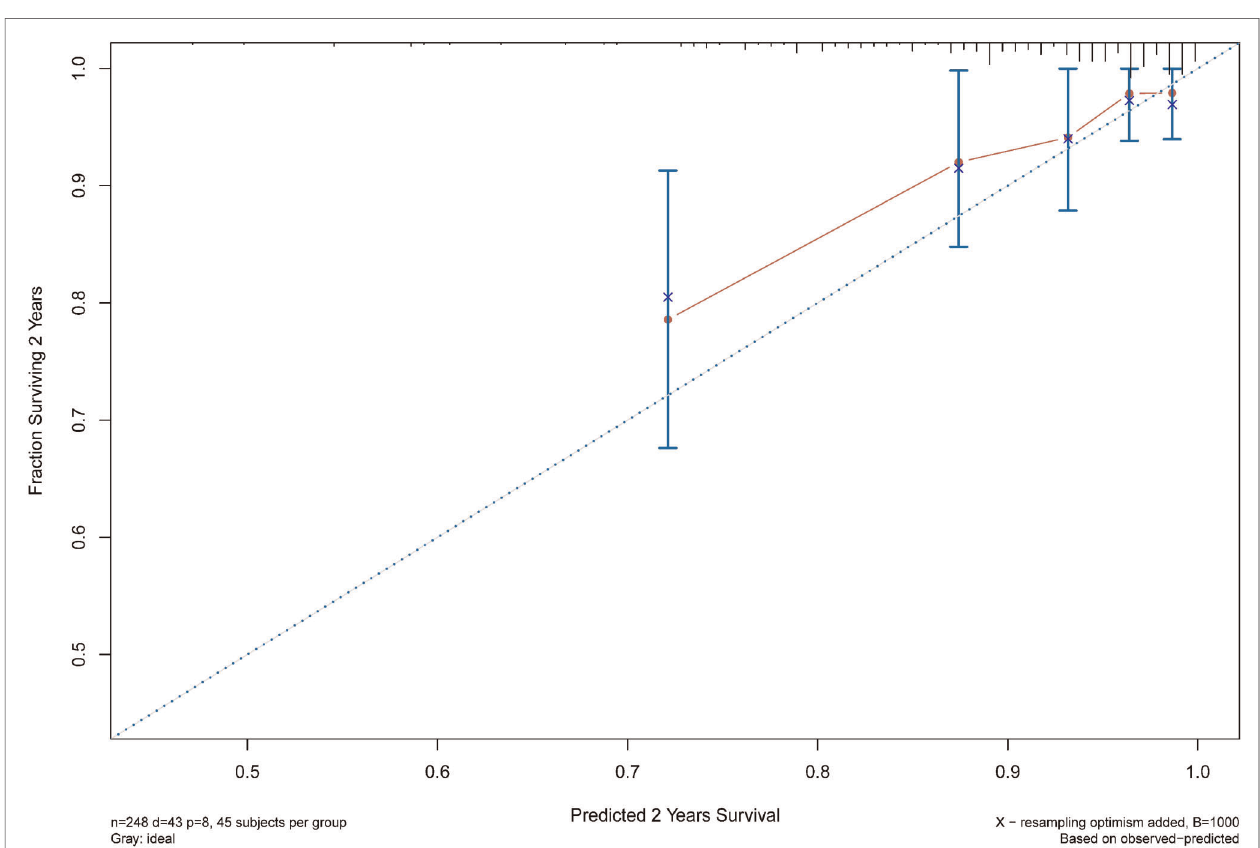
FIGURE 4 | The calibration curves for evaluation of the consistency between the actual and the predicted hip survival rates. Satisfactory consistencies were showed on 2-year survival probability.